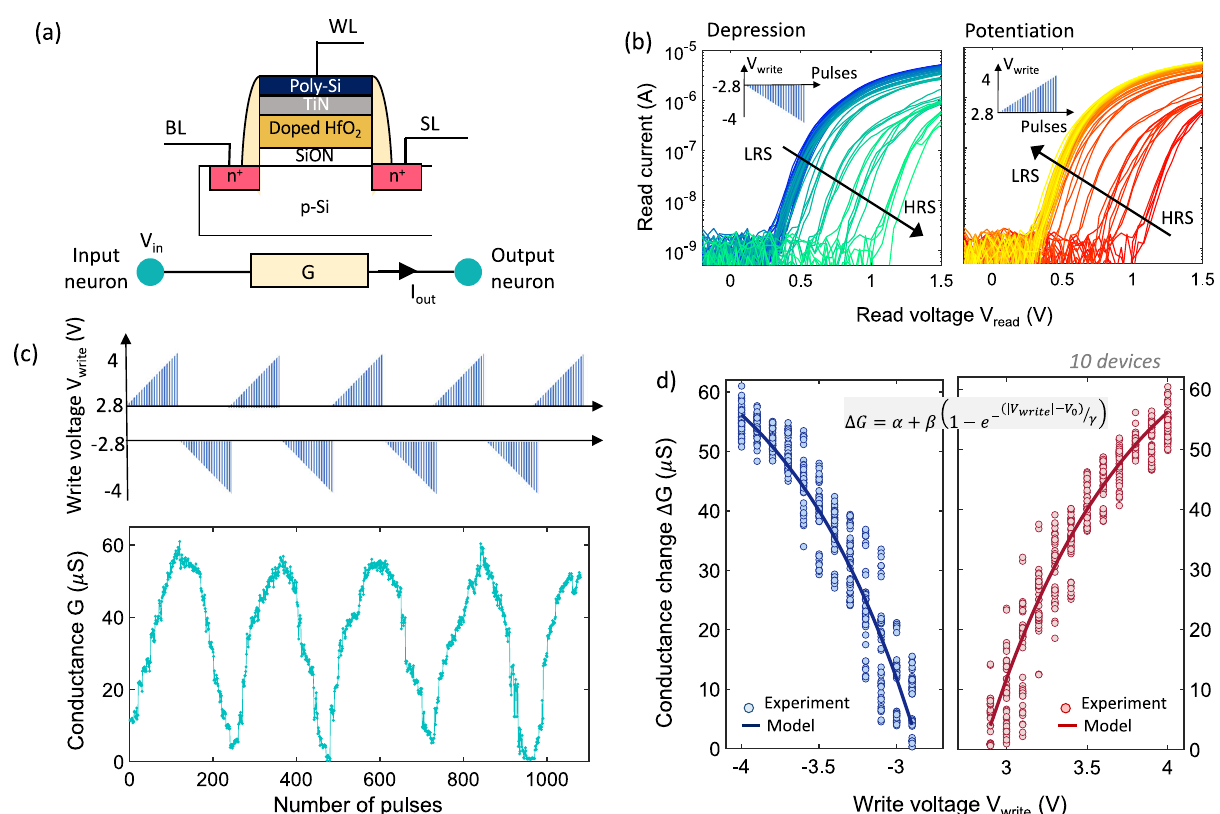
Fig. 2 FeFET-based analog synapse. a Schematic of a stand-alone FeFET-based analog synapse. The channel conductance can be modulated by applying write pulses ± V write to the gate of the FeFET while reading out the conductance state is achieved by applying a small read voltage V read to the gate terminal. b Experimentally measured conductance modulation in a 500 nm × 500 nm high-K metal gate FeFET fabricated at 28 nm technology node. An amplitude modulation scheme is used where positive and negative write voltage pulses V write of increasing amplitude from 2.8 V to 4 V and pulse widths of 1 μ s are applied to modulate the conductance of the FeFET. c Measured continuous change in the conductance state of the FeFET upon applying multiple potentiation and depression pulses of varying amplitude. d The FeFET-based analog weight cell is modeled in the NSM by fi tting the conductance update scheme for both potentiation and depression with the closed-form expression as shown in the fi gure. WL word line, BL bit line, SL source line, V in input voltage, I out output current, V write write voltage, G conductance, LRS low resistance state, HRS high resistance